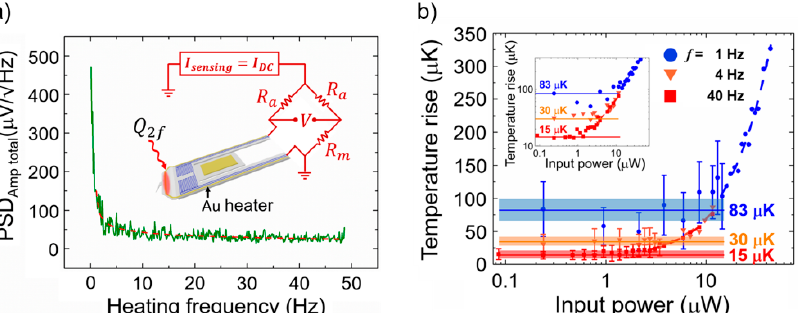
Figure 4. ( a ) Measured PSD of thermal noise in the calorimeter of the SThM probe. Inset shows the Wheatstone bridge circuit used for temperature resolution measurement. R a and R m are the resistance and matching resistance, respectively. ( b ) Measured temperature rise of the probe using a lock-in amplifier, when the heater line is excited using sinusoidal heating currents (0.5, 2.0, and 20 Hz). Solid lines show the estimated noise floor. Dashed line represents a trend line of temperature. Error bars reflect the standard deviation in the RMS value measured by the lock-in amplifier. Shaded areas represent the noise region where the temperature cannot be measured. Inset presents the same data in a log-log plot. The temperature of the probe is proportional to the input power in the temperature range beyond the temperature resolution.